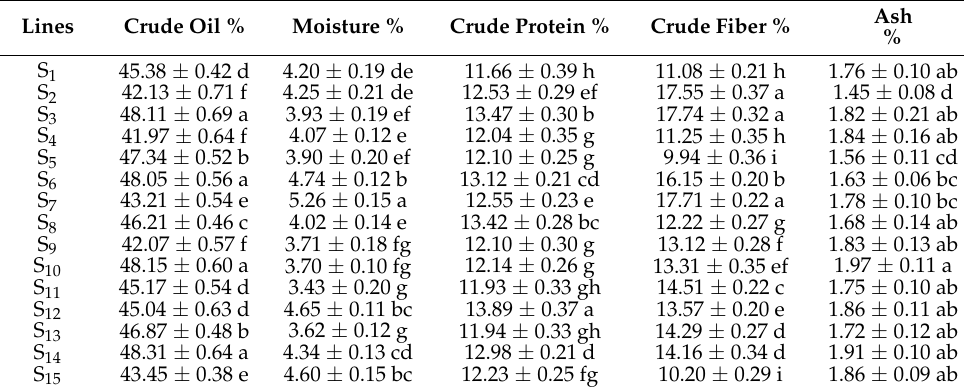
Table 1. Chemical constituents of the seeds of elite jojoba lines. Lines